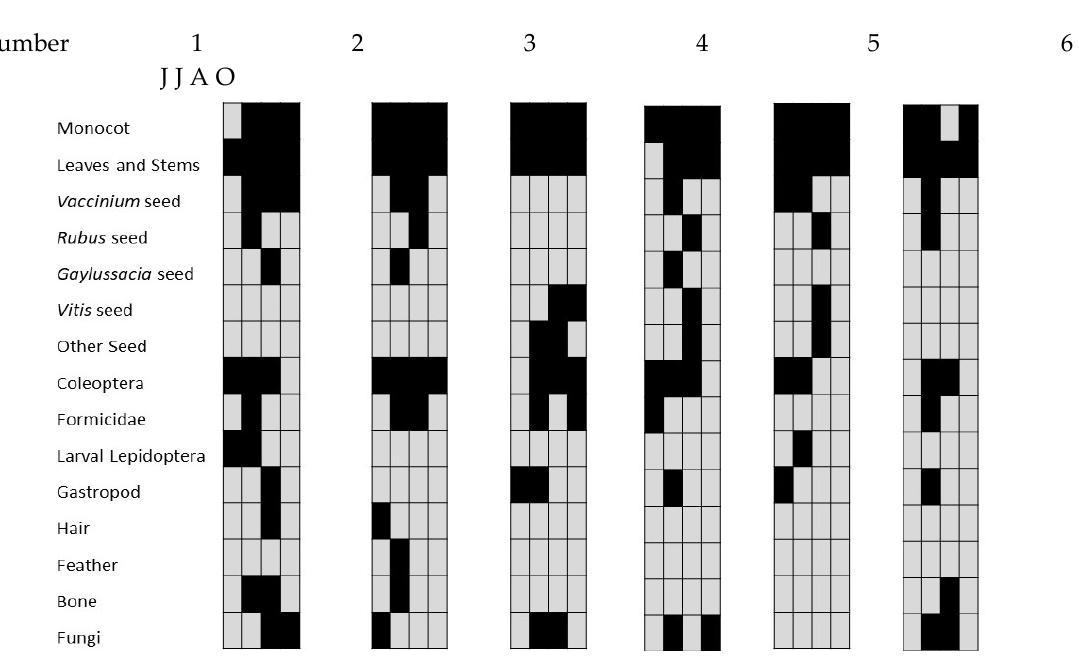
Figure 1. The presence (black)/Absence (gray) of prey in each diet category detected in the feces of the six individual Eastern Box Turtles sampled during every sampling period June, July, August, October, from left to right. Table 1. Percent frequency of the occurrence of prey in diet categories detected in the feces of Eastern Box Turtles in June, July, August, and October 2014, New York. Sample sizes in